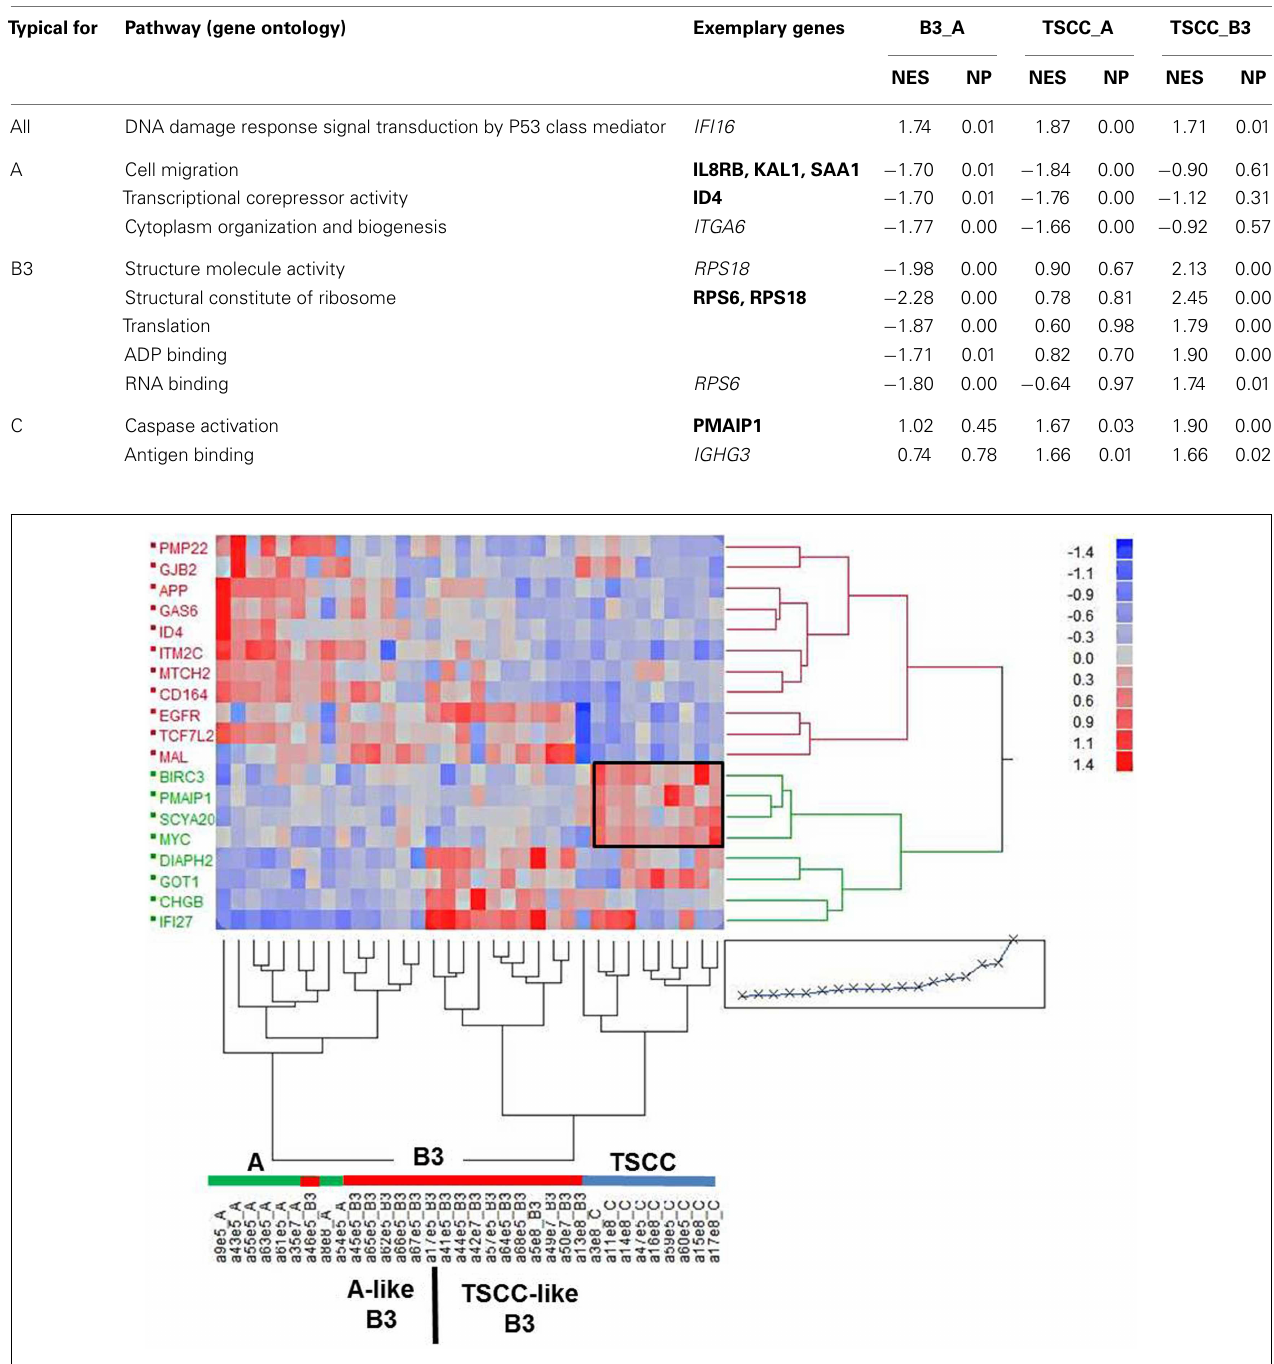
FIGURE 2 | Cluster analysis of 19 expressed genes in individual epithelial-predominant typeA and B3 thymomas andTSCC based on a fold-change > 1.5, p < 10 − 4 and low variance (var < 0.07) in at least one of the cohorts of tumors . One of the two main clusters (left) harbors all of the